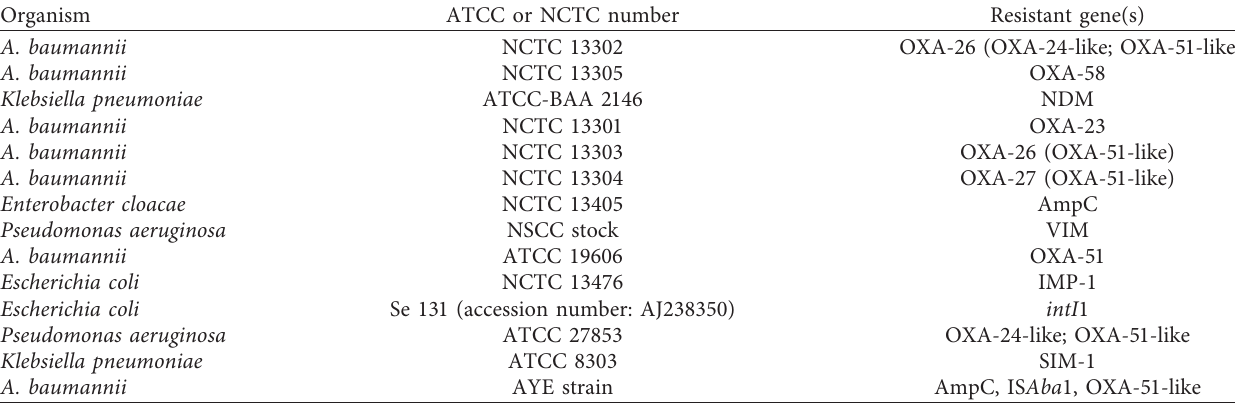
Table 1: Quality control (QC) organisms used for the detection of resistant genes in this study.